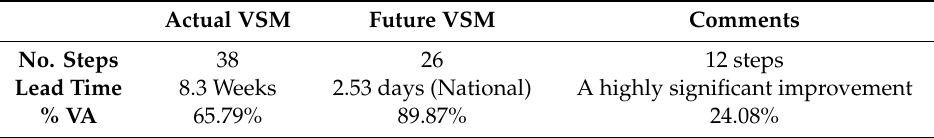
Table 8. Expected Benefits after implementation second